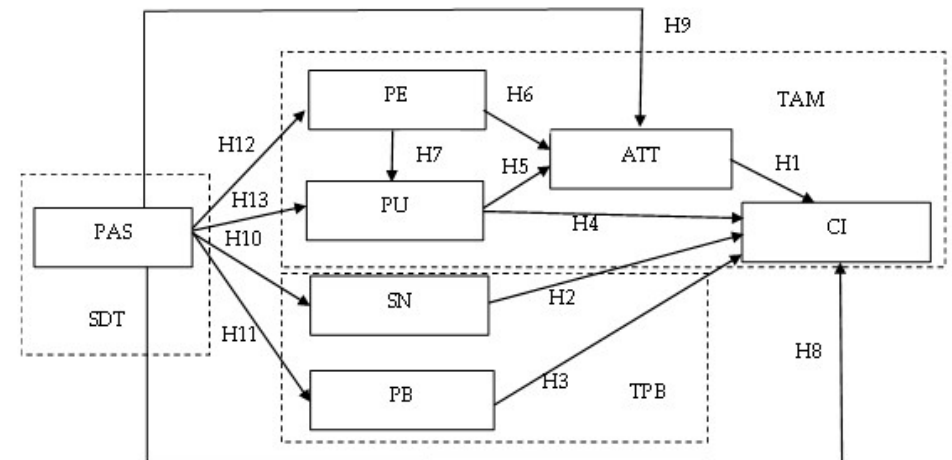
Figure 1. The Proposed Research Model. Note: PAS: Perceived Autonomy Support, PE: Perceived Ease of Use, PU: Perceived Usefulness, SN: Subjective Norm, PB: Perceived Behavior Control, ATT: Attitude, CI: Continuance intention.